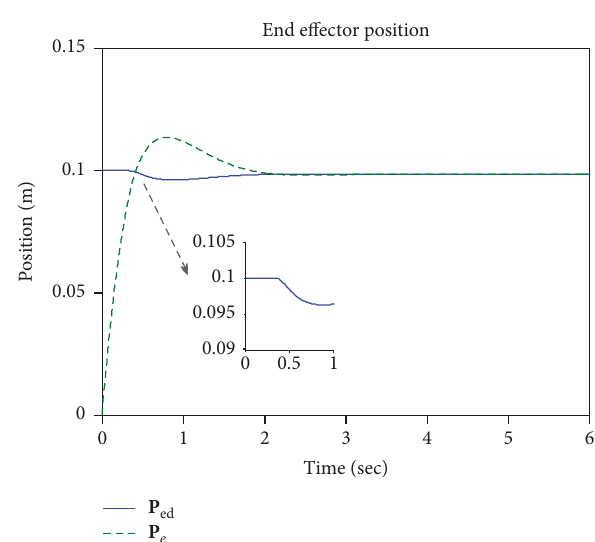
Figure 13: Desired and actual position of the end e ff ector in the body